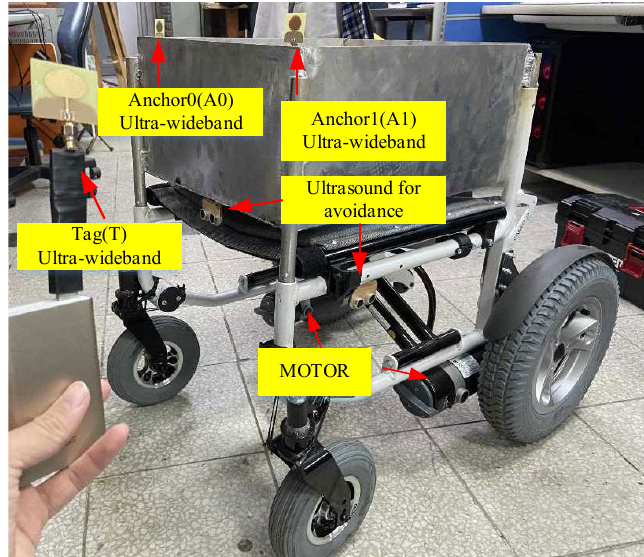
Figure 1. Block diagram of intelligent following system hardware.